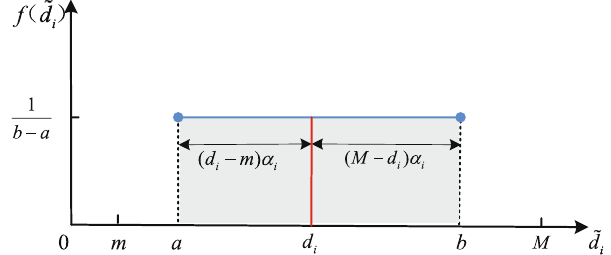
is the probability density function i